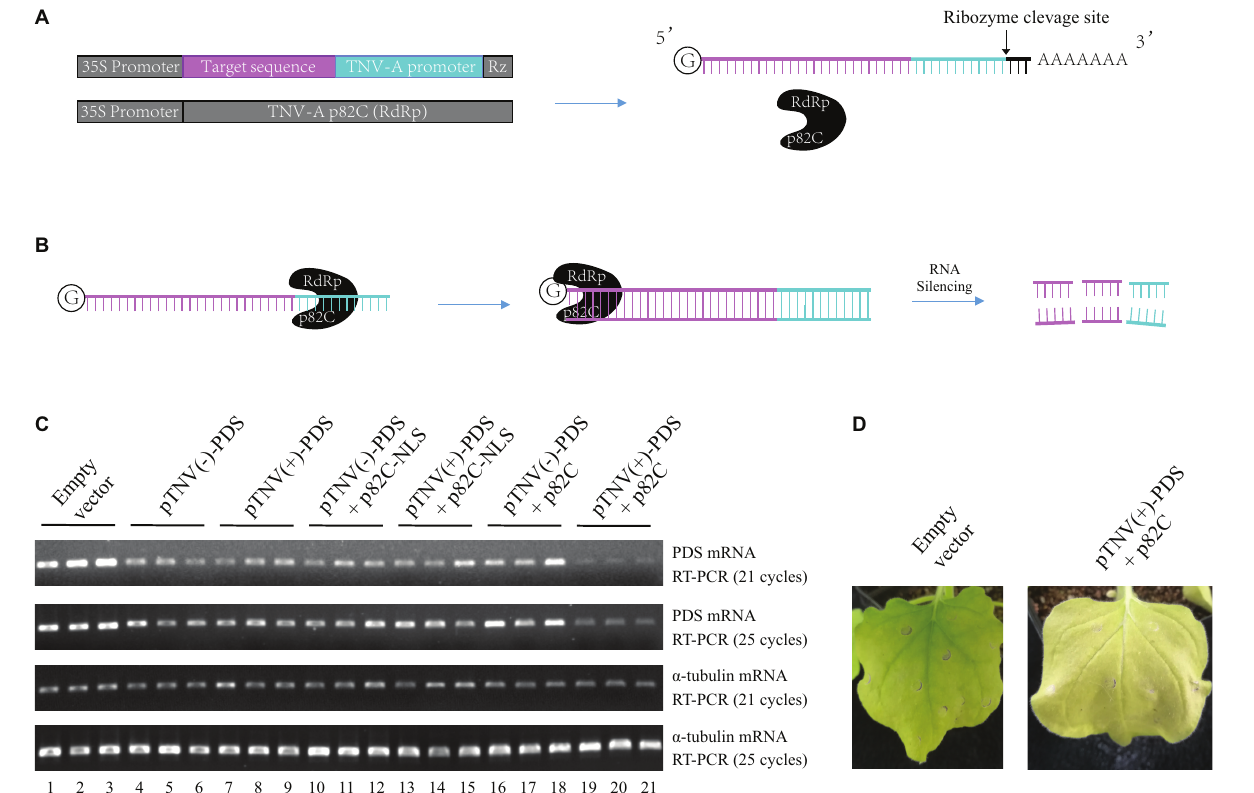
FIGURE 1 | The viral RdRp-assisted gene silencing vectors induce silencing of PDS. (A) Scheme of the VRAS vectors. The first vector containing both a 35S promoter and a TNV-A positive strand RNA initiation promoter provides the sense-strand RNA for dsRNA synthesis. The second vector is used for the expression of a truncated form of TNV-A RdRp p82C. (B) The p82C RdRp recognizes the TNV-A promoter to initiate synthesis of the complementary strand of the sense-strand RNA, then the dsRNA generated by the VRAS system leads to RNA silencing of the target gene. (C) The TNV-A promoters for positive-strand or negative-strand RNA synthesis and p82C proteins targeted to the nucleus or the cytoplasm were tested for their ability in inducing the PDS silencing in the VRAS system. Agrobacteria transformed with pCB301-314-pTNV(+)-NbPDS-Rz, pCB301-314-pTNV( − )-NbPDS-Rz, pGD-2 × 35S-L-TNV-p82C, or pGD-2 × 35S-L-TNV-p82C-NLS were mixed as shown and infiltrated into N. benthamiana leaves (OD 600 of 0.5, each). Semiquantitative PCR of 21 or 25 cycles was performed to measure the mRNA levels for PDS or α -tubulin coding genes at 2 dpi. (D) Image of the plant leaf silenced for PDS gene at 10 dpi. Each experiment was repeated three times.